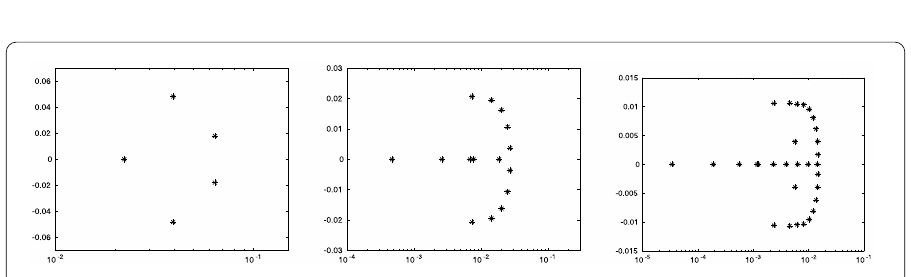
Figure 9 Eigenvalues of U n in the case of an algebraic/logarithmic weight function with parameter α = 1/2 for n = 5,15,30 (from left to right)